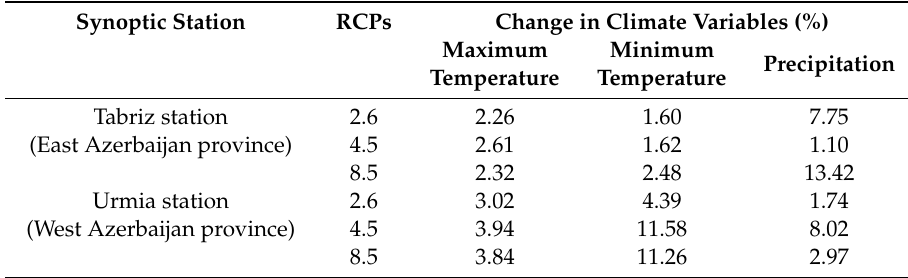
Table 3. Percentage change in climate parameters of dryland wheat-growing period for